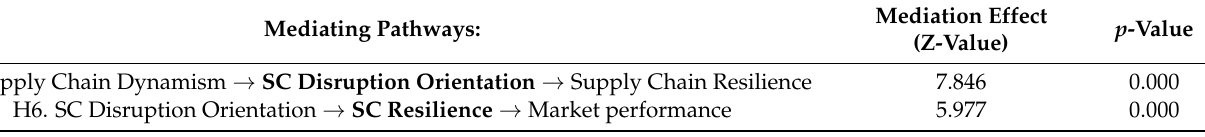
Table 8. Mediation